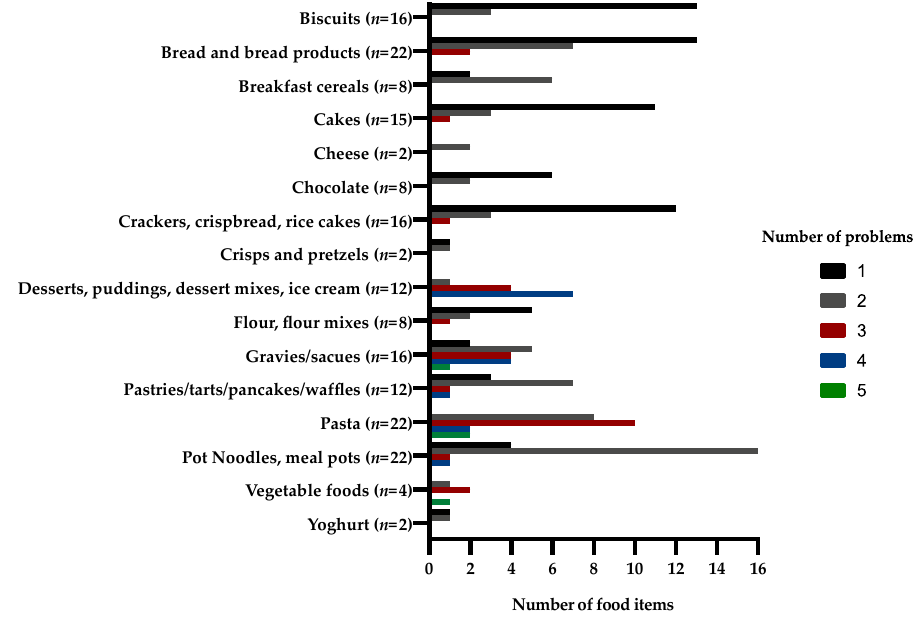
Figure 2. Frequency of misleading, omitted, or erroneous (MOE) information for regular food items that would affect their protein content given on the supermarket websites.